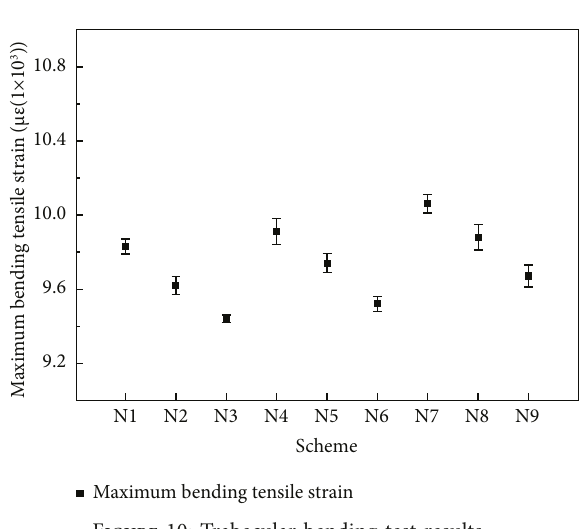
Figure 10: Trabecular bending test results.